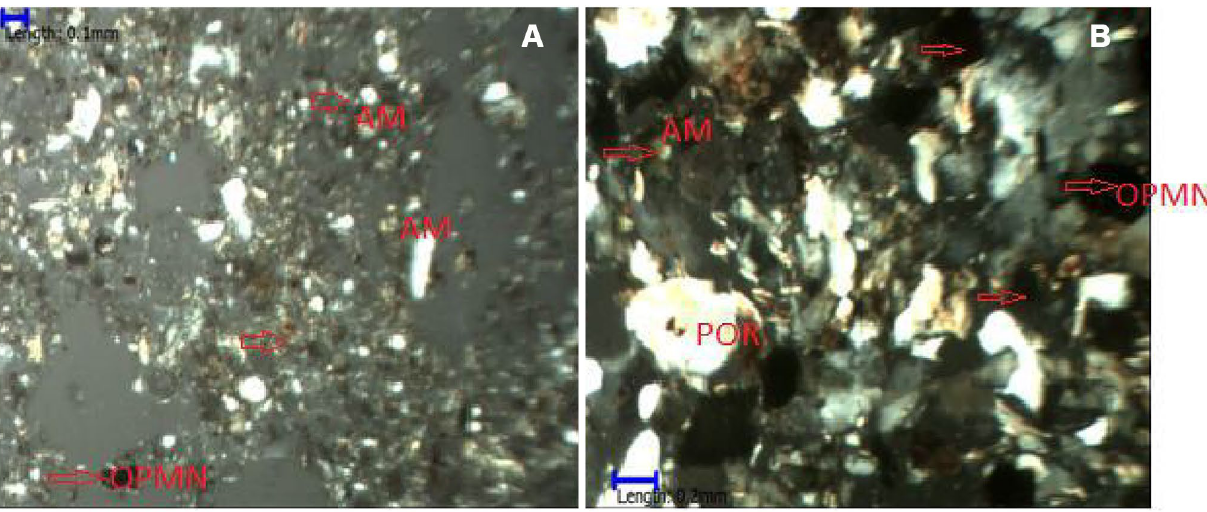
Fig. 13 a, b Showing accessory mineral particularly apatite grain in Ayede-Ajegunle at depth 75–78 m under plane polarised light (PPL) and at Araromi-obu/Ago-Alaye at depth 84 m under plane polarised light (PPL)